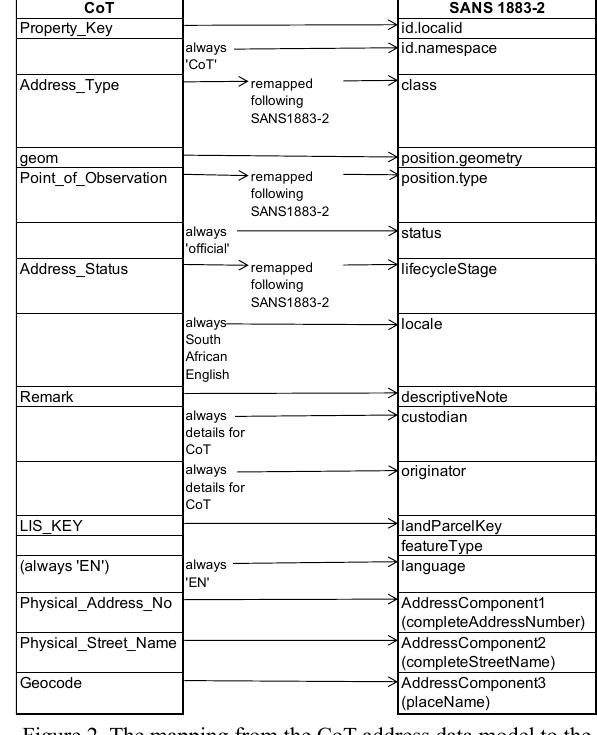
Figure 2. The mapping from the CoT address data model to